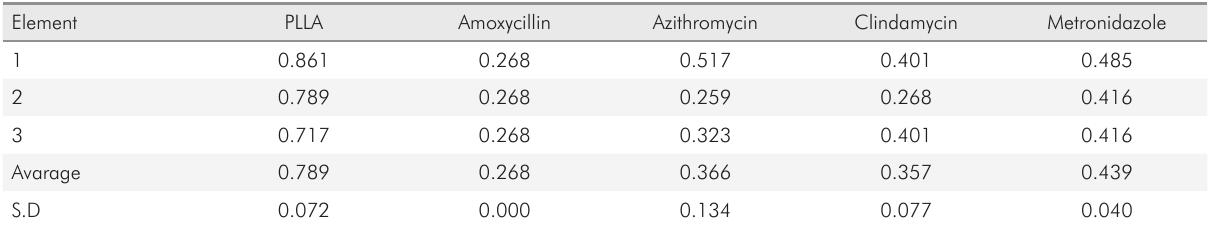
Table. Fiber diameter.